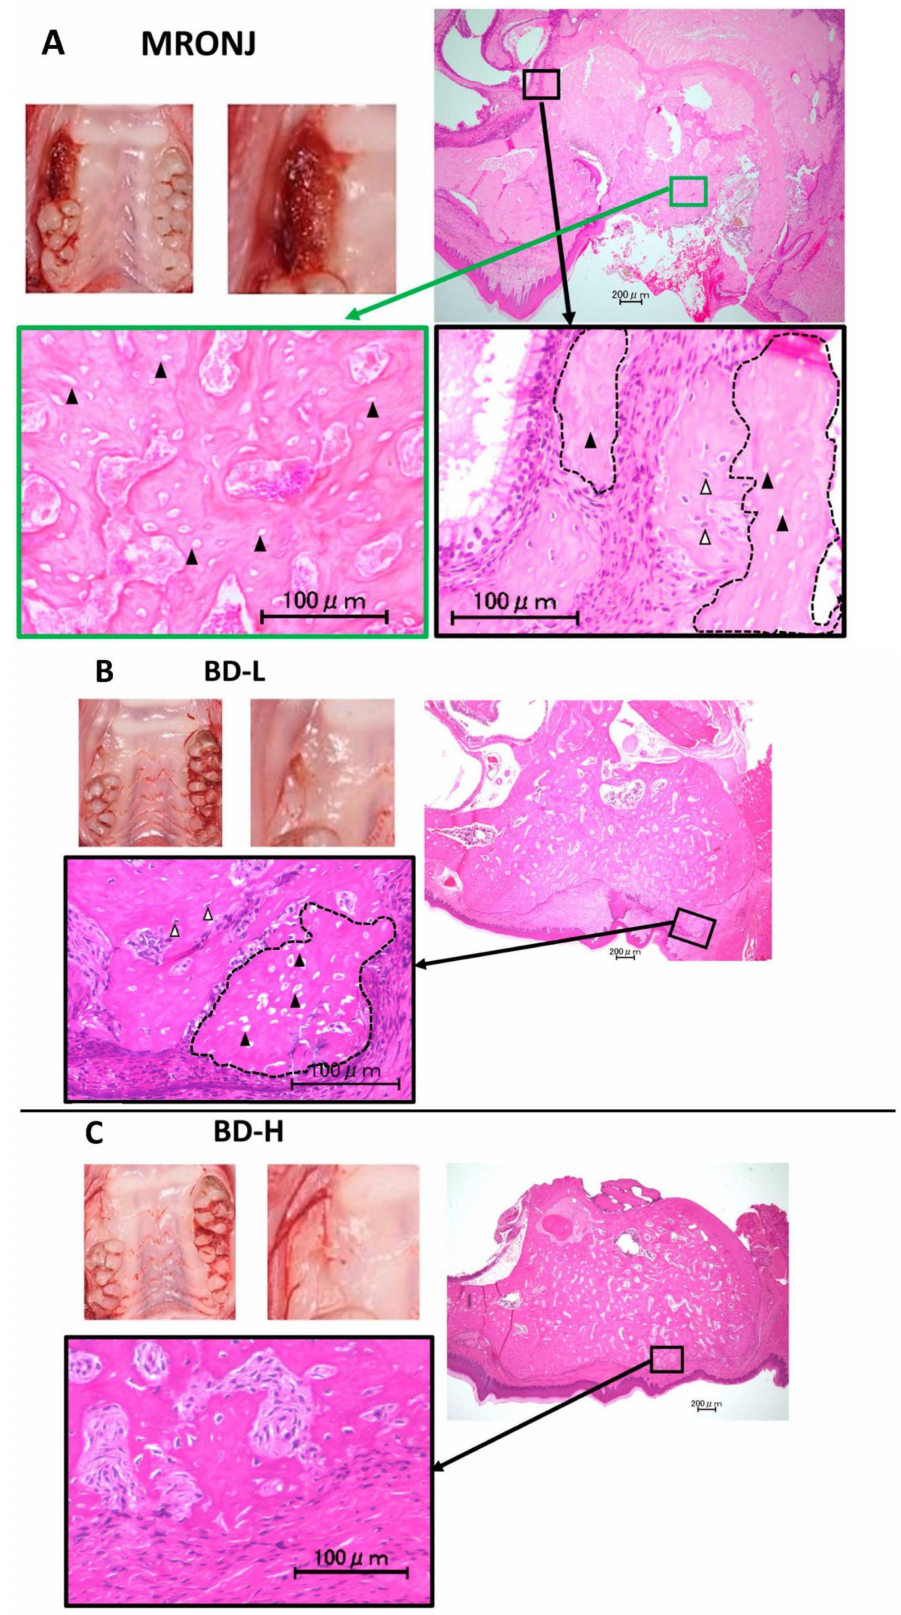
Figure 1. Intraoral and histological findings four weeks after extraction of the upper right first molar. ( A ). In the MRONJ group, epithelial continuity is disrupted, and necrotic bone characterized by